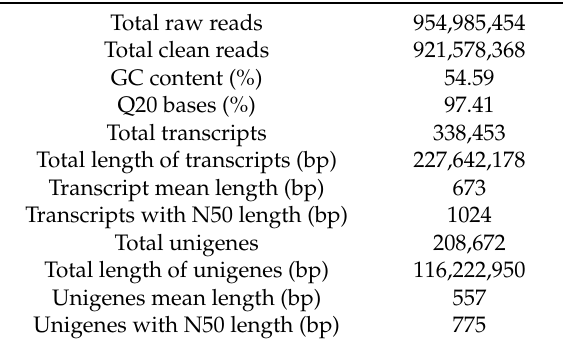
Figure 2. Histogram of the sequence-length distribution of transcripts and unigenes by De novo assembly. Table 1. Assembled transcripts and unigenes of all creeping bentgrass samples.